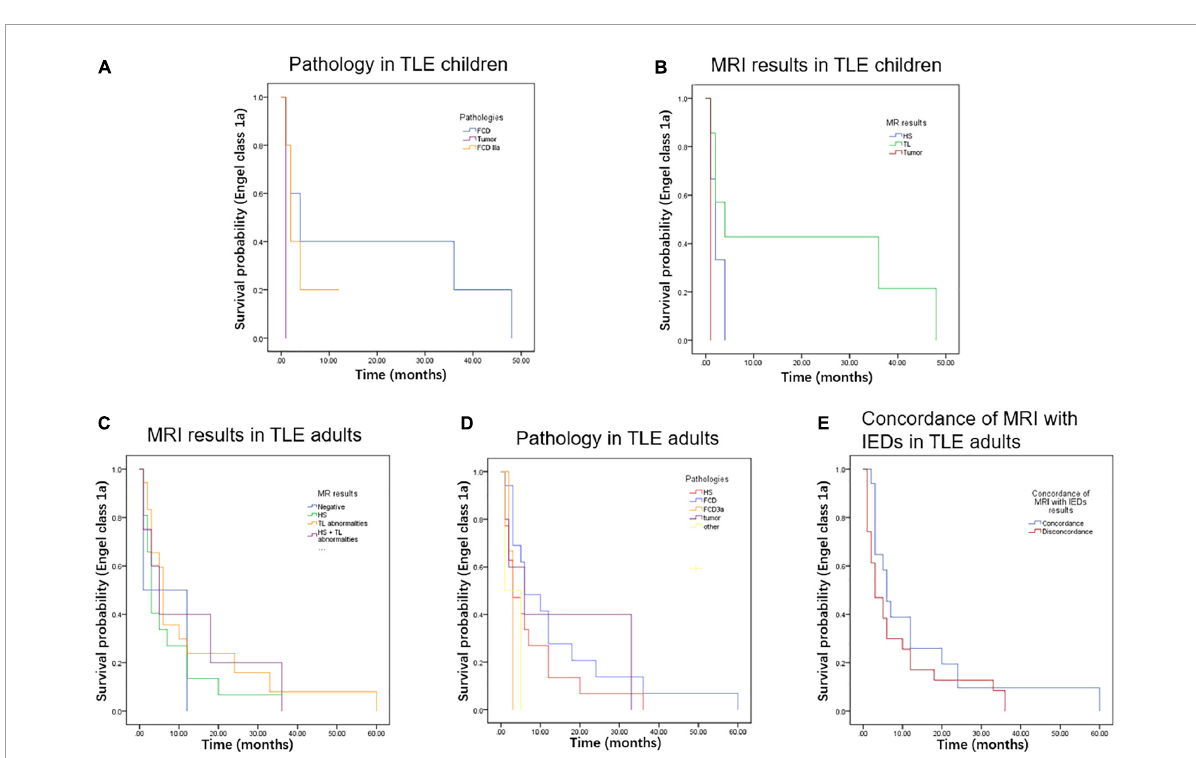
FIGURE4 The Kaplan-Meier estimates of the probability of cumulative seizure-free survival in months were not a significant difference in those TLE children with different pathologies (A) , different MRI results (B) , in those TLE adults with different MRI results (C) , different pathologies (D) , and concordance of MRI with IEDs (E)